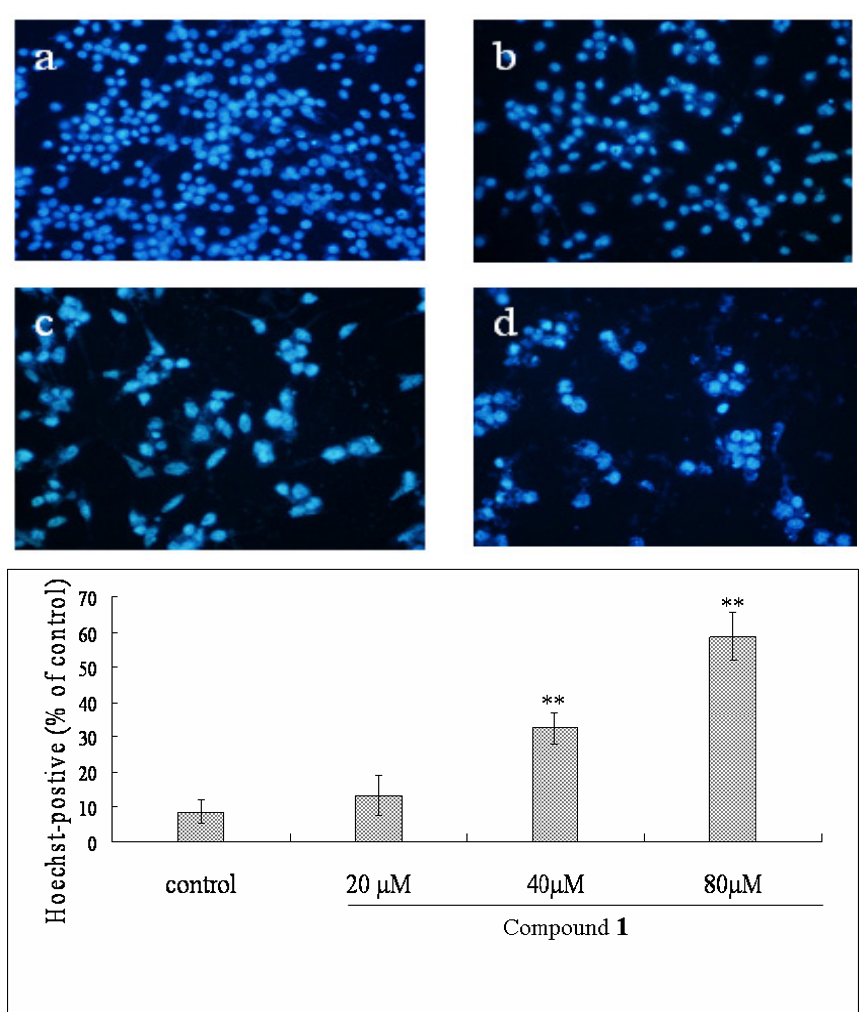
Figure 3. Compound 1 induced apoptosis of Bel-7402 cells for 48 h. Effect of compound 1 on Bel-7402 cells morphological change by hoechst 33258 staining (×200): ( a ) Control cells proliferated normally and cells appeared enlarged with prominent nuclei; ( b-d ) The addition of compound 1 (20, 40 and 80 μ M) to the cultures of Bel-7402 cells showed dose-dependent inhibition of cell growth, the nuclei exhibited bright condensed chromatin. Compound 1 led to individual cell to shrink and separate from consecutive